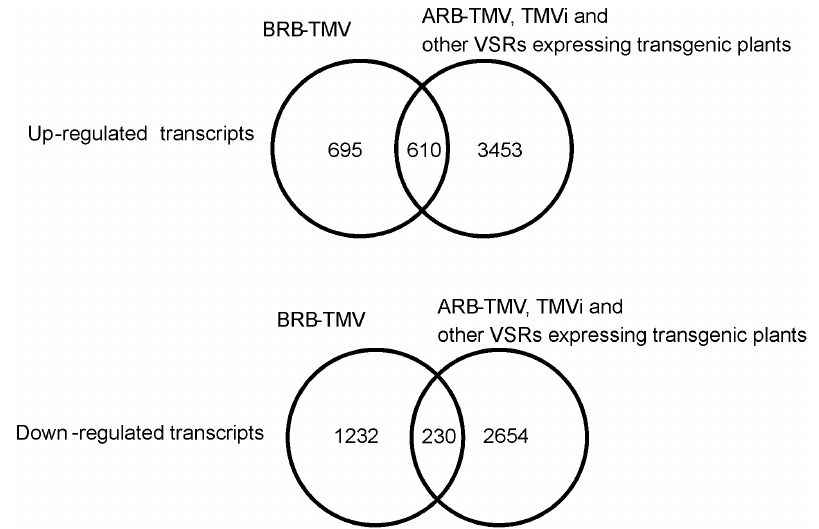
Figure 3. A Venn-diagram showing the numbers of up- and down-regulated transcripts that are either uniquely altered in the BRB- TMV transgenic plants, or in in the ARB-TMV transgenic plants or in the TMVi plants, or in the transgenic tobacco lines that express various viral silencing suppressors (as described in the text), and numbers of genes that are detected both in the BRB-TMV plants and in some of the other plants.